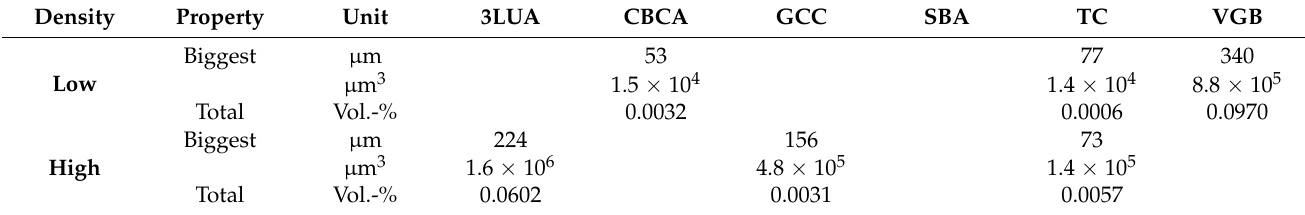
Figure 4. Cross sections of local discontinuities identified by µ XCT in CAD/CAM RBCs (HT). Table 4. Properties of local discontinuities identified by µ XCT in CAD/CAM RBCs (HT). Density Property